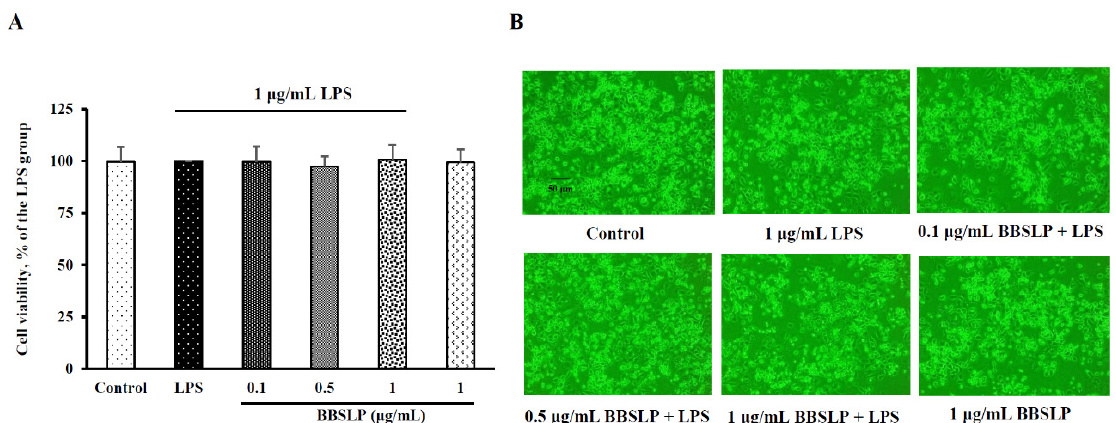
Figure 2. Effects of BBSLP on the viability of LPS-induced RAW264.7 cells. RAW264.7 cells (1 × 10 5 cells/30-mm plate) were seeded and cultured overnight, treated with 0.1, 0.5 or 1 µ g/mL BBSLP for 24 h and then induced or not with 1 µ g/mL LPS for another 24 h. The group treated with 1 µ g/mL LPS alone served as an induced control group. BBSLP was diluted in sterilized H 2 O, and cells treated with sterilized H 2 O alone served as the control group. Cells treated with 1 µ g/mL BBSLP without LPS treatment for 48 h were used as another control group. Cell viability ( A ) and morphological changes ( B ) were examined. Values are presented as means ± SD ( n = 3–5). abc Values are significantly different from the other groups as determined by Tukey’s test ( p < 0.05).